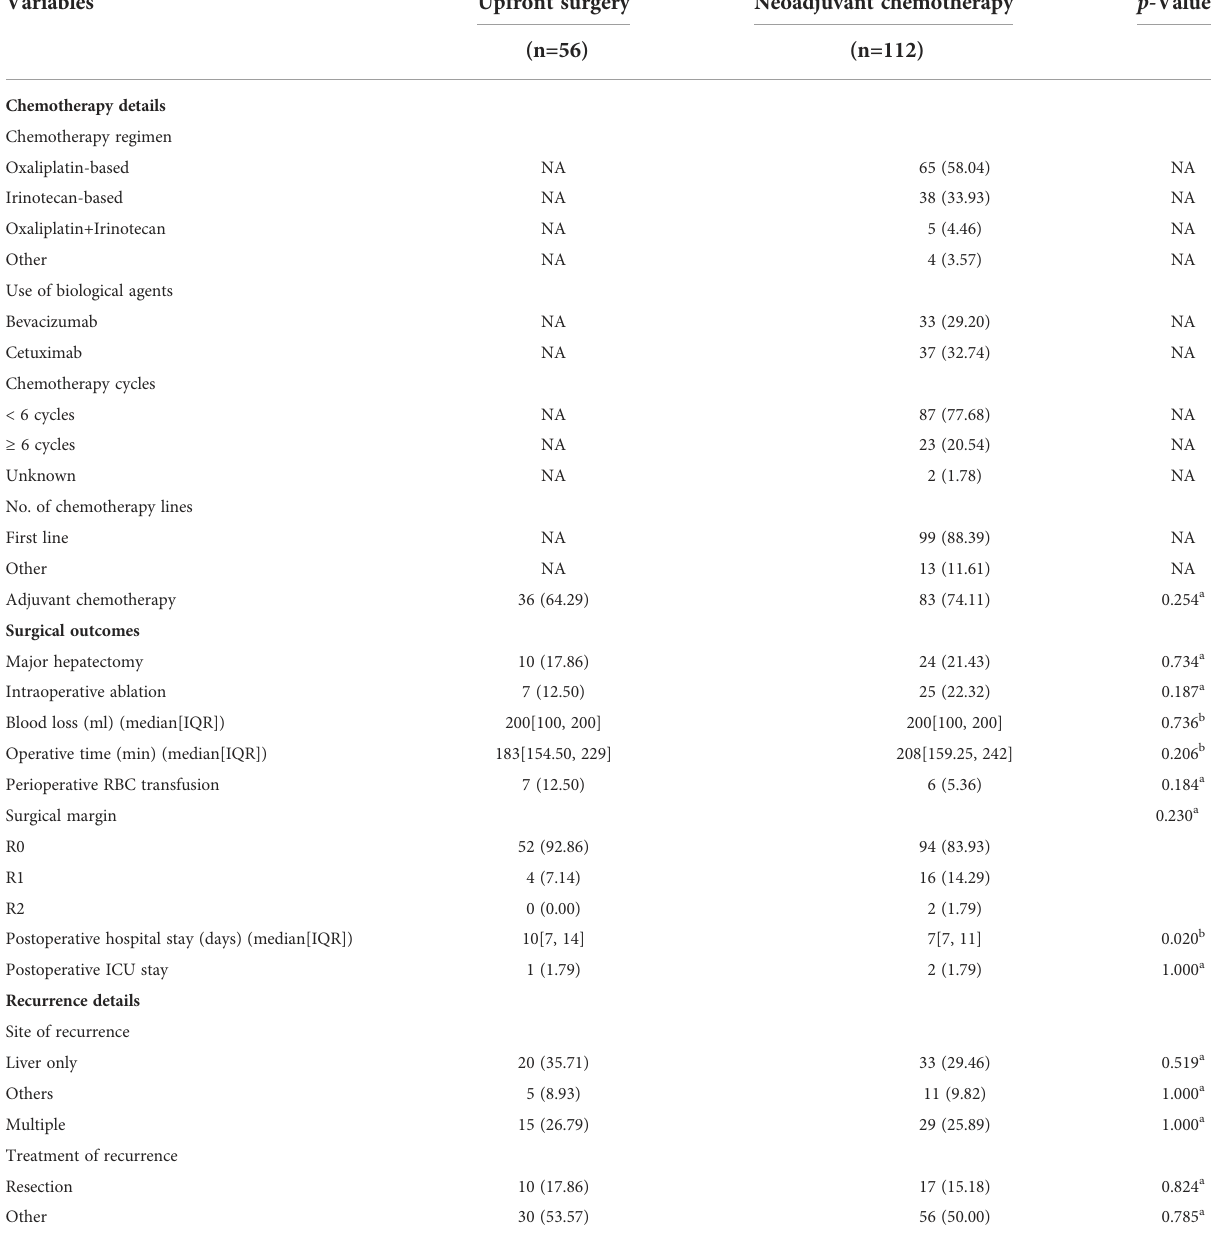
TABLE 2 Chemotherapy details, surgical outcomes, postoperative complications, and recurrence details for patients with upfront surgery or neoadjuvant chemotherapy after Propensity Score Matching analysis. Variables Upfront